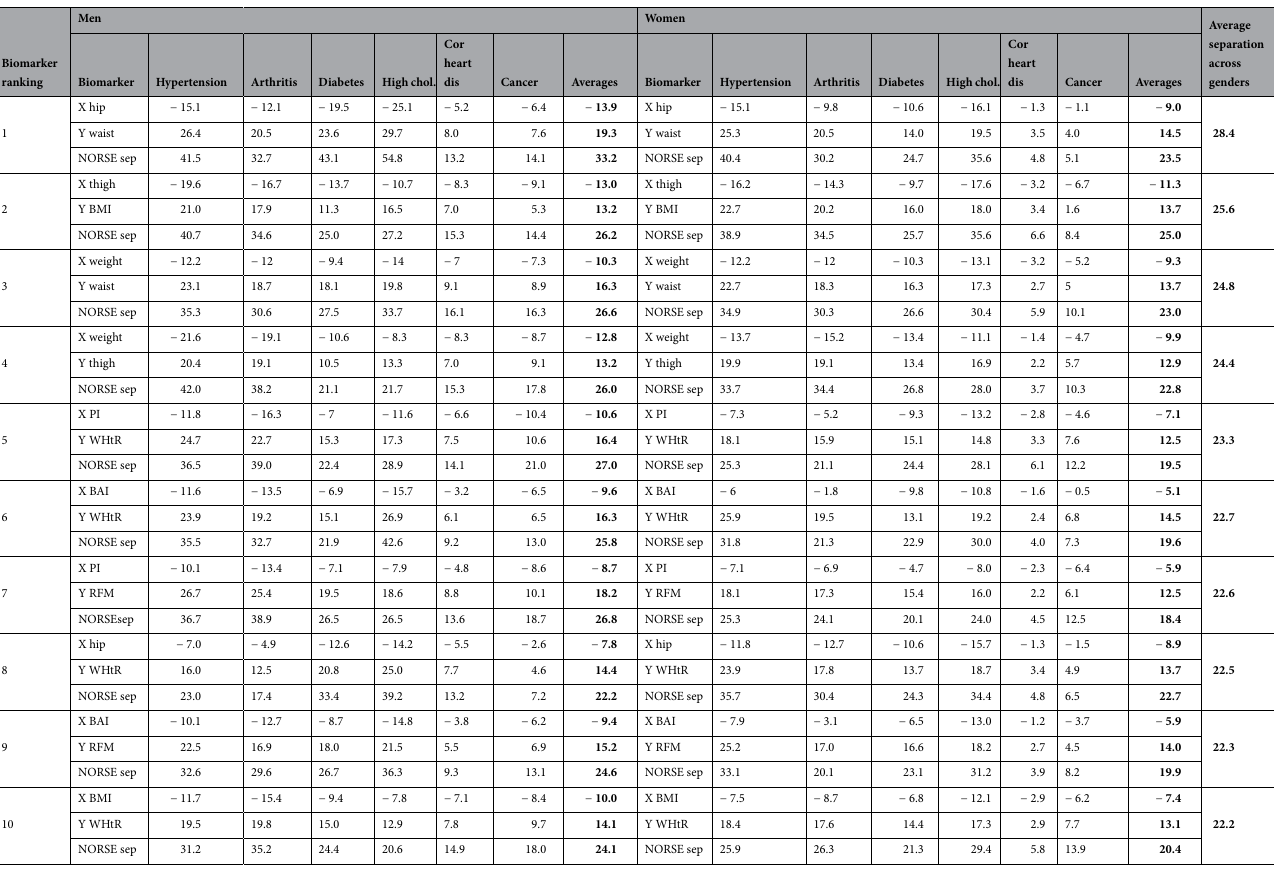
Table 2. Ranking of 2D biometric models. NORSE values calculated for 10 different biomarker pairs (in rows) and 6 health conditions (in columns), for adult men and women. In average 2D models yield higher NORSE values than in 1D models. Average values for each gender are in